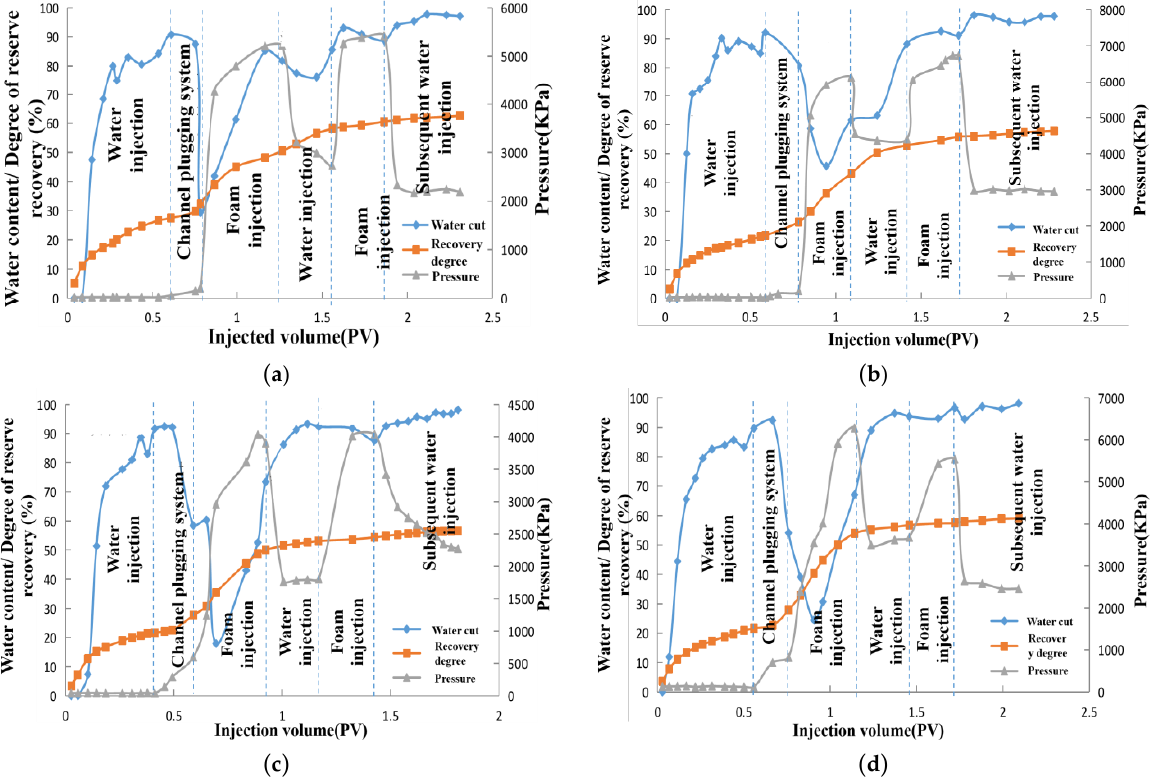
Figure 5. Dynamic curves of oil displacement experiments with intra-layer heterogeneity. (Note: These four scheme ( a – d ), all show the relationship between water content/Pressure/Degree of reserve and injection volume at different stages.)